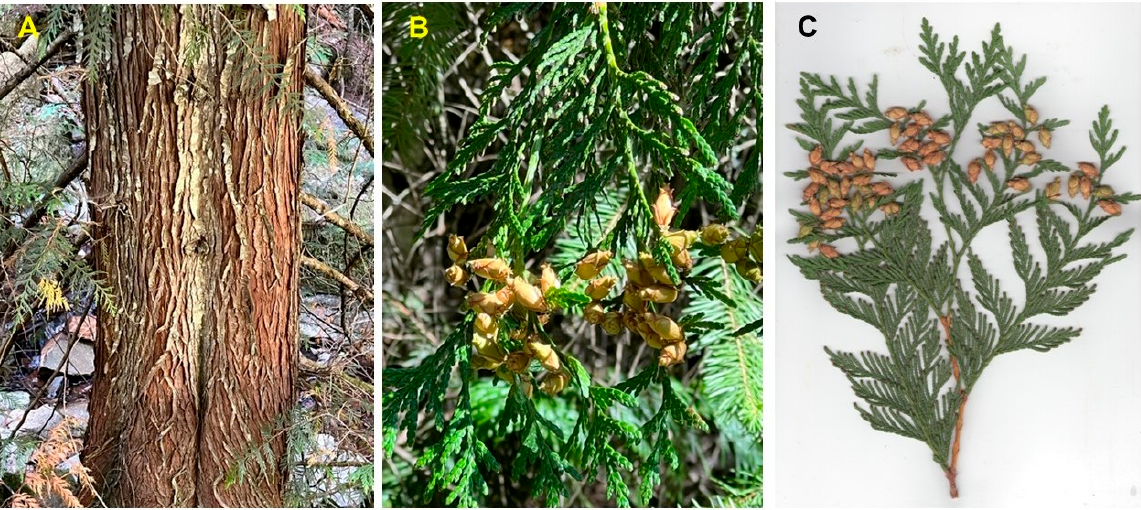
Figure 10. Thuja plicata from northern Idaho. ( A ): bark. ( B ): foliage and cones. ( C ): scan of foliage and cones. Photographs by K. Swor.